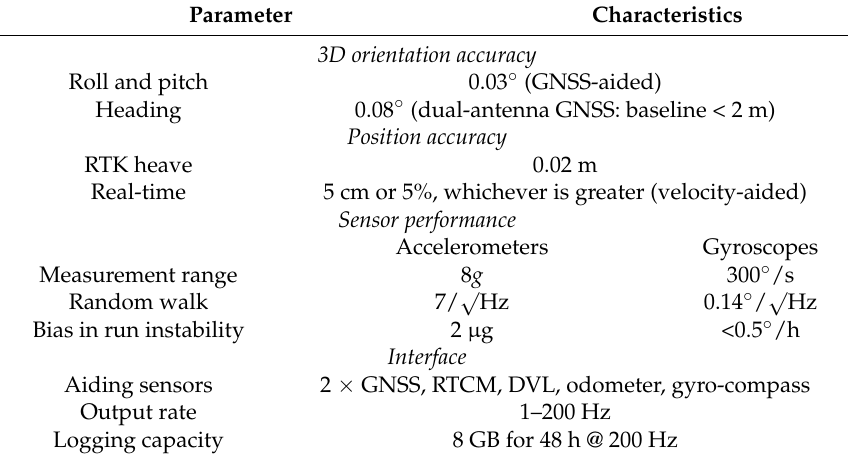
Table 3. Specifications of the Ekinox 2-D outdoor inertial navigation